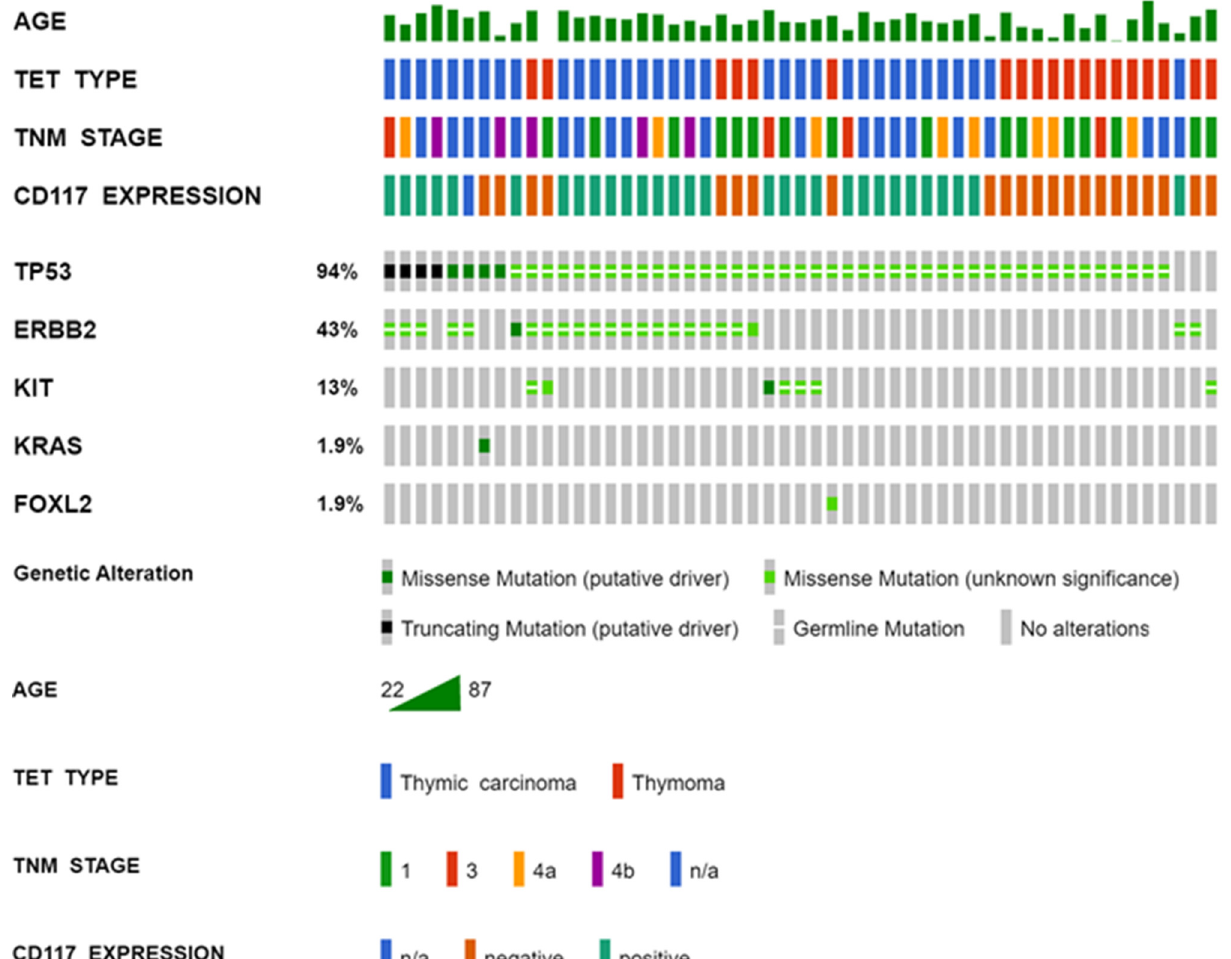
Figure 1. The OncoPrint showing the distribution of genetic alterations within 15 targeted genes in 53 thymic epithelial tumours (TETs). The types of mutations are labelled in the colour legend, particular genes in rows, and tumour samples in columns.